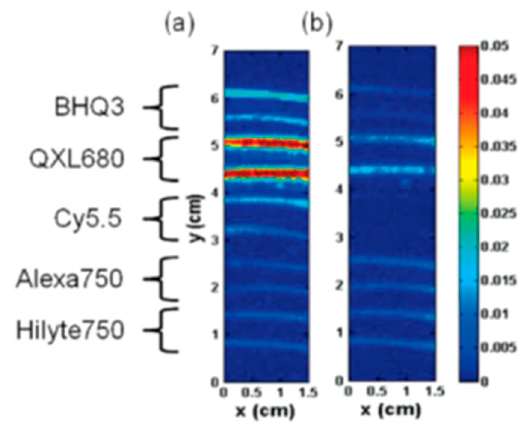
Figure 12. Relative optoacoustic signals from BHQ3, QXL680, and a variety of NIR dyes with 675 ( left ) and 750 nm ( right ) excitation. Figure from [93] reproduced with permission from the publisher.